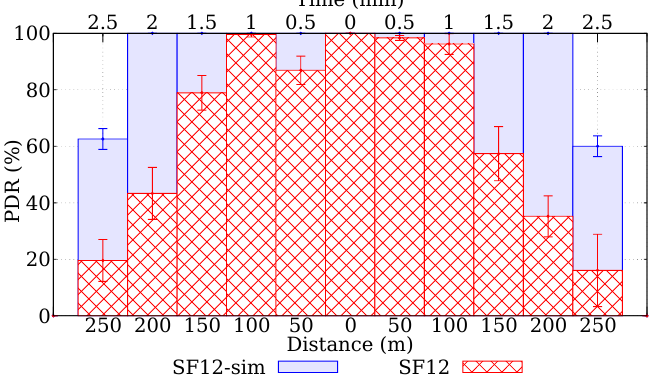
Figure 19. PDR vs. distance—100m/min—simulated vs.